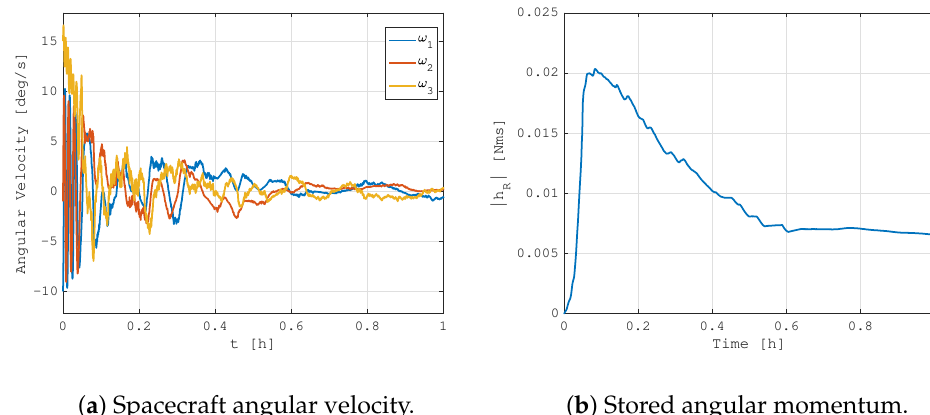
Figure 12. MIL simulation of velocity dumping